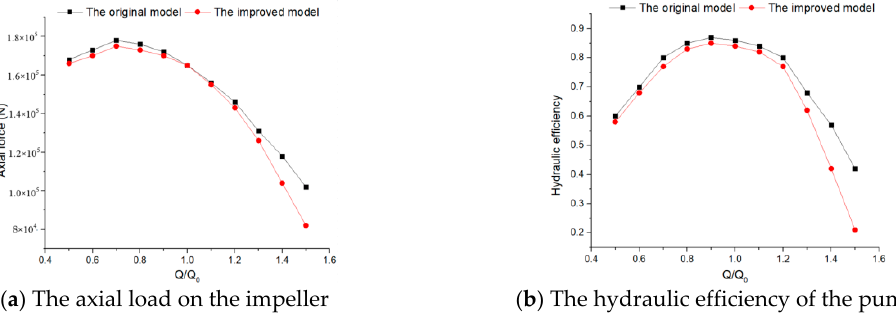
Figure 8. Comparison of hydraulic performance before and after impeller improvement.